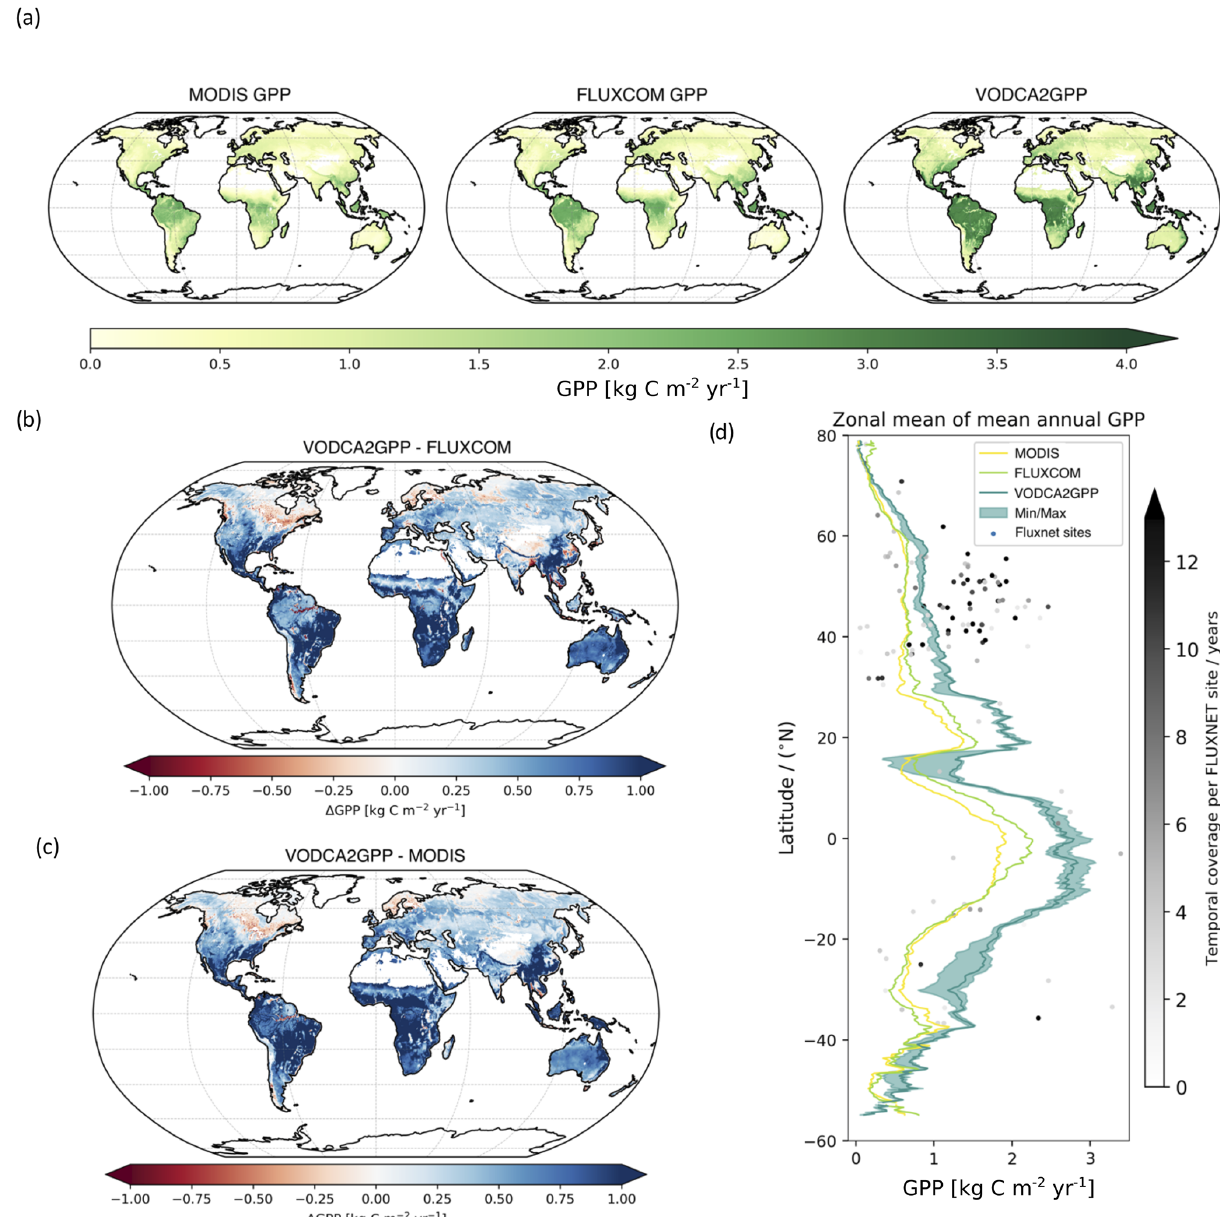
Figure 1. (a) Mean yearly aggregated GPP for the common observation period of the three products VODCA2GPP, MODIS, and FLUXCOM (2002–2016); (b, c) difference in mean annual GPP between VODCA2GPP and FLUXCOM and MODIS, respectively; (d) latitude plot of zonal means of mean annual GPP. The means were computed based on 8d, 0.25 ◦ sampling. The Min/Max area denotes the minimum– maximum latitudinal mean for the 10 model runs that were obtained with the site-based cross-validation. The dots represent the latitudinal location of the FLUXNET sites and their corresponding mean annual GPP. The brightness of the dots indicates the data availability for the respective FLUXNET station. Only pixels and observation dates that are available in all three datasets were used for these